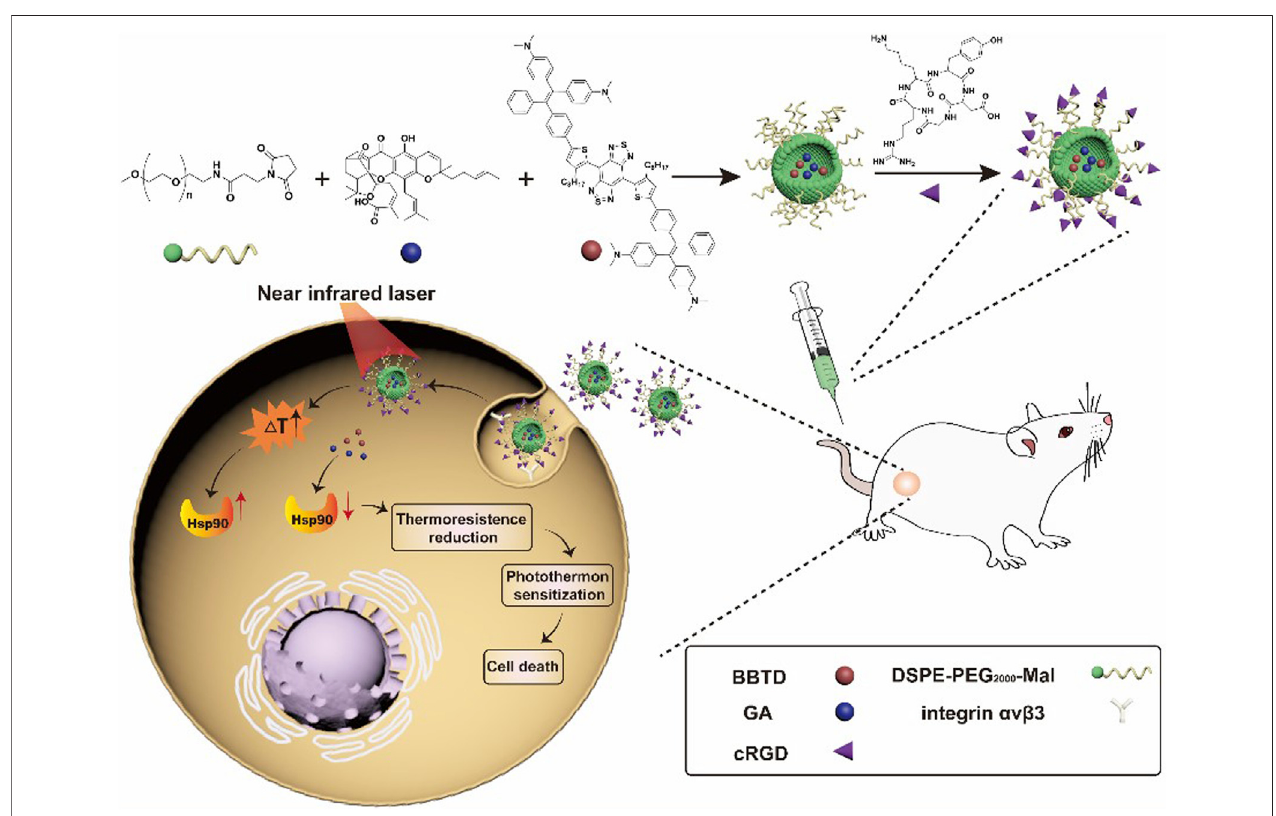
FIGURE 3 | Schematic illustration of synthesizing BBTD + GA/PEG-cRGD nanoparticles for photohyperthermia therapy of MIBC(Zeng et al., 2021a).